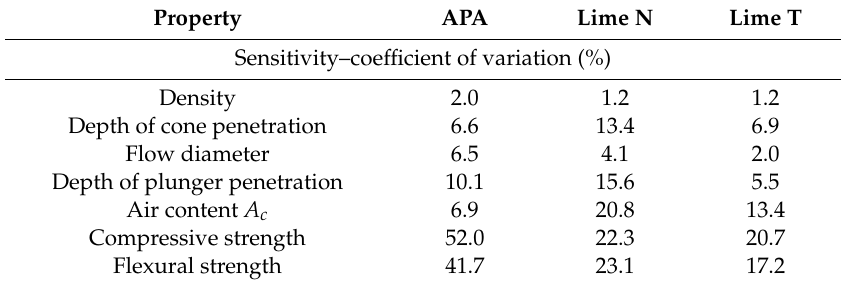
Table 24. The sensitivity of masonry mortar properties to temperature